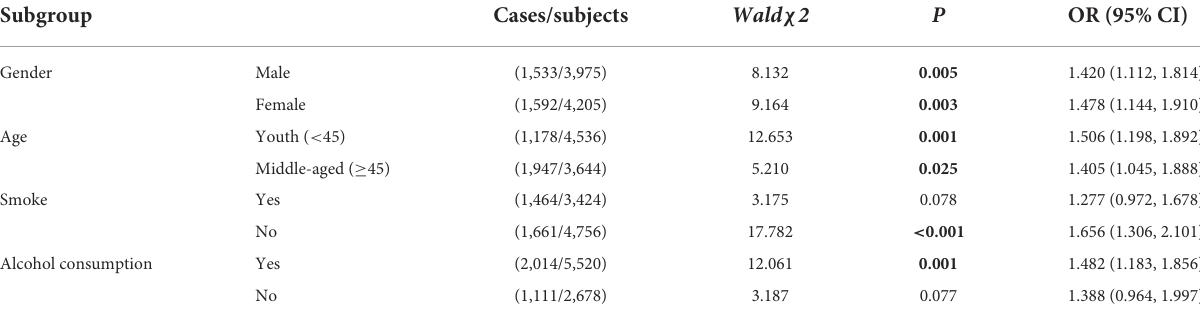
TABLE 3 Subgroup analysis of the association of DII and MetS.